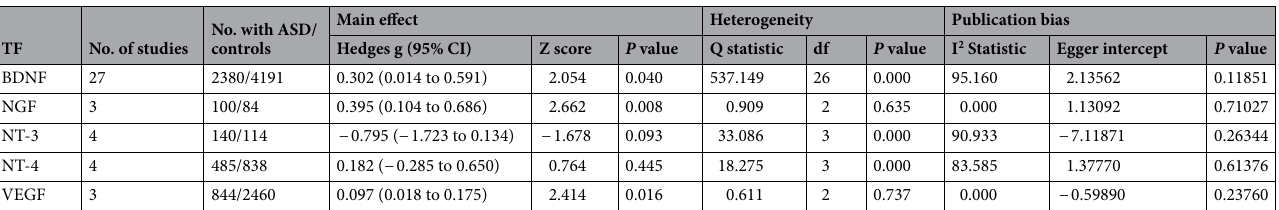
Table 1. Summary of comparative outcomes for measurements of neurotrophic factor levels. df, degrees of freedom; ASD, Autism Spectrum Disorder; BDNF, Brain-Derived Neurotrophic Factor; NGF, Nerve Growth Factor; NT-3, Neurotrophin-3; NT-4, Neurotrophin-4; VEGF, Vascular Endothelial Growth Factor; NTF, Neurotrophic